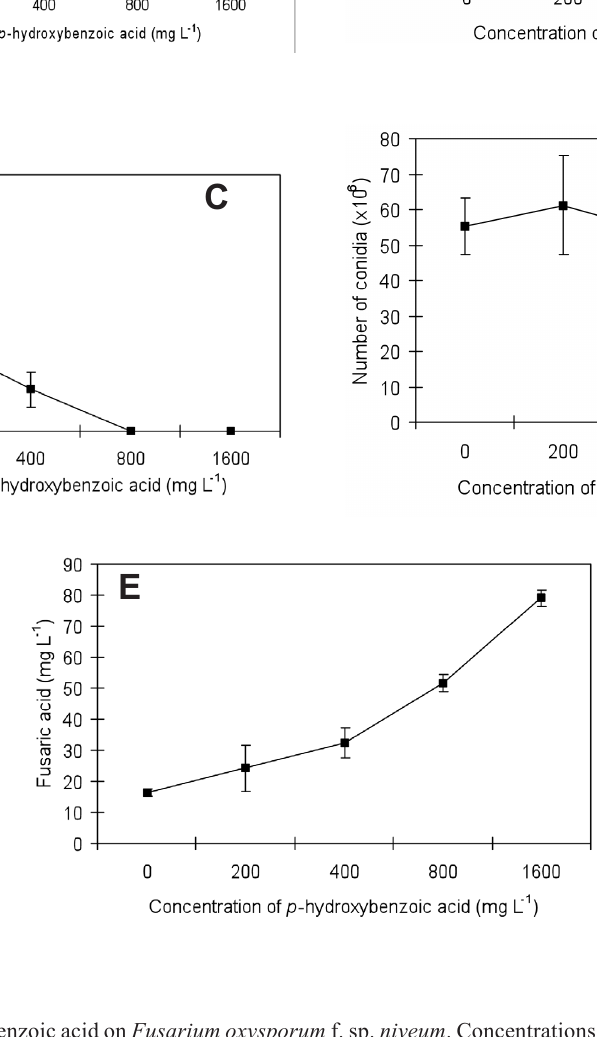
Figure 1. Effect of p -hydroxybenzoic acid on Fusarium oxysporum f. sp. niveum . Concentrations of 0, 200, 400, 800 and 1600 mg L -1 of p -hydroxybenzoic acid were tested. Bars indicate standard deviation of three replicates for each treatment. A) Effect on mycelial mass. The inoculated fungus was incubated at 28°C, 180 rpm. B) Effect on colony growth. The colony was grown on PDA at 28°C. C) Effect on conidia germination. The conidia were germinated on PDA without dextrose at 28°C. D) Effect on sporulation of F. o. f. sp. niveum in a potato dextrose liquid culture at 28°C, 180 rpm. E) Effect on fusaric acid production. The inoculated fungus was incubated at 28°C, 180